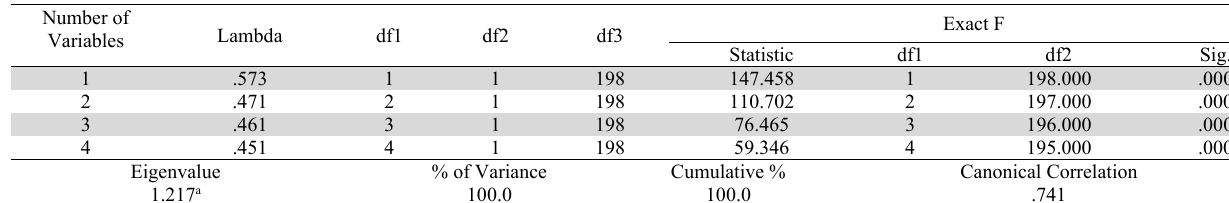
Wilk’s Lambda Number of